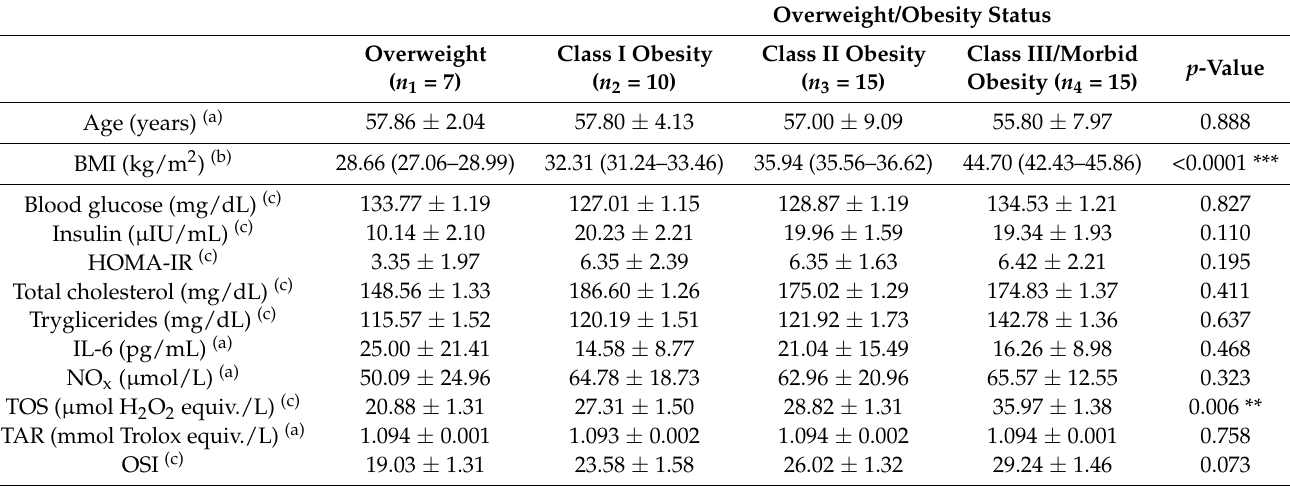
Table 1. Main demographic, anthropometric and laboratory characteristics according to overweight/obesity status ( n = 47, 27 female, 20